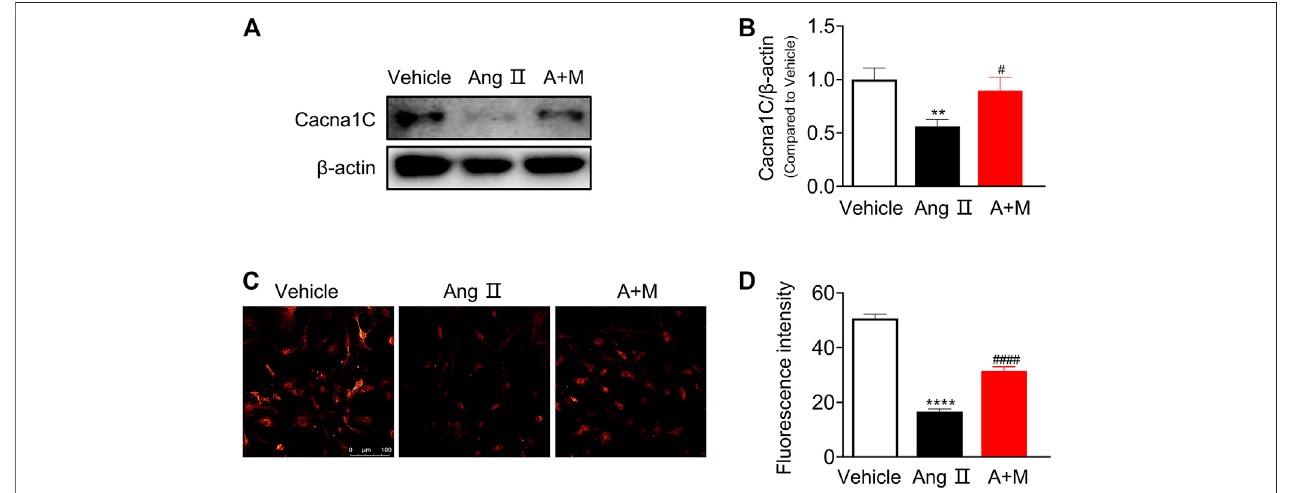
FIGURE6| Cacna1c expression and Ca 2+ level.Proteinexpressions ofCacna1c weredownregulated inthe aortic endothelialcellsfrom hypertensive mice,which were rescued by MK-626 (A – B) . The reduced Ca 2+ level was also restored after MK-626 administration in the endothelial cells of hypertensive mice (C – D) . ** p < 0.01, **** p < 0.0001 vs Vehicle; # p < 0.05, #### p < 0.0001 vs Ang Ⅱ .Dataareexpressedasmean ± SEM( n (cid:1) 4 – 6forWesternblot;n (cid:1) 80individualcellsforthemeasurementof Ca 2+ level, scale bar (cid:1) 100 μ m). A + M, Ang Ⅱ +